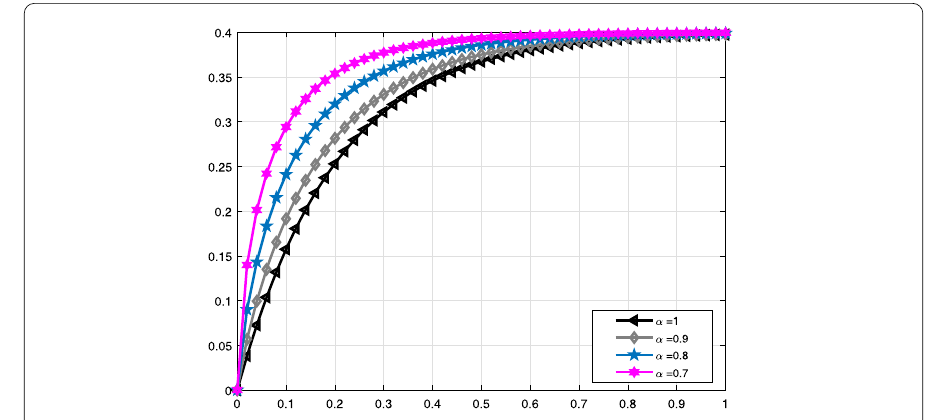
Figure 1 Comparative analysis with truncated M -derivative for V i ( t ), β = 0.8